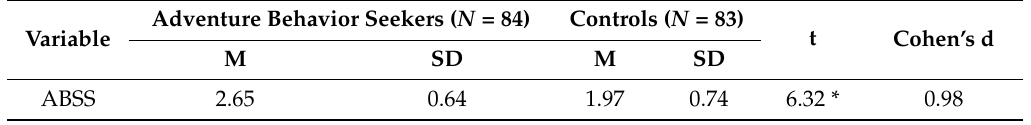
Table 4. The Adventure Behavior Seeking Scale and Outdoor